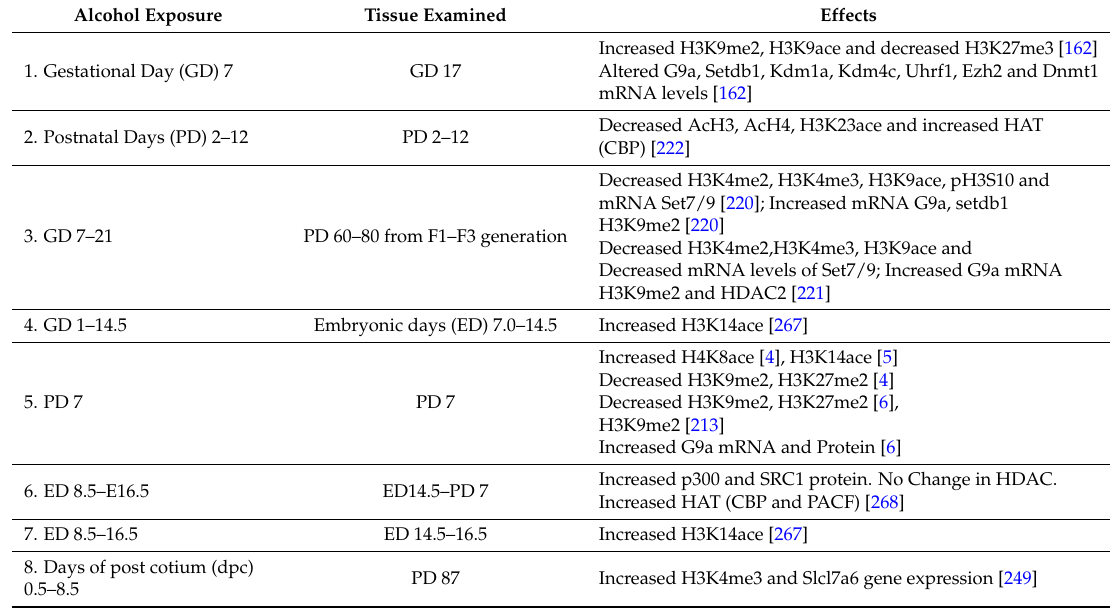
Table 2. Influence of developmental alcohol on histone